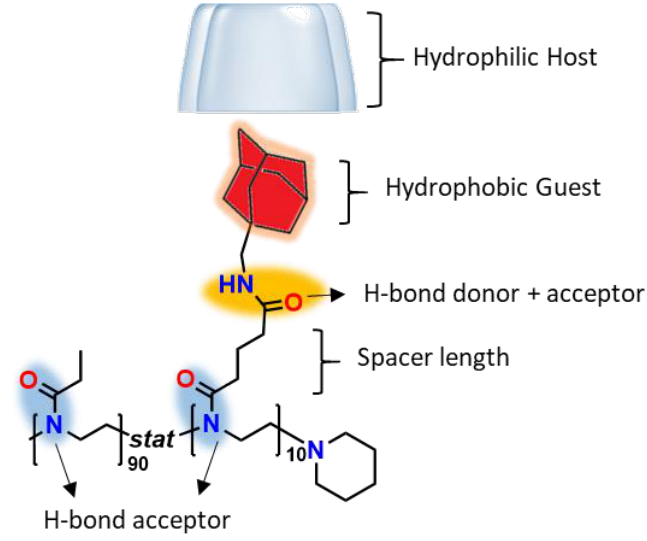
Figure 7. Rationalization of the polymer design.